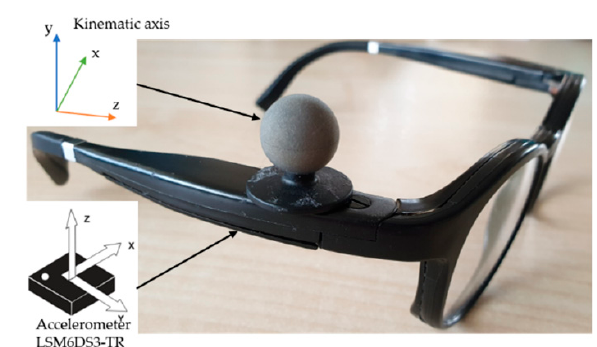
Figure 1. Position of the reflective marker on the right arm of the glasses and axes of the accelerometer and reflective marker.